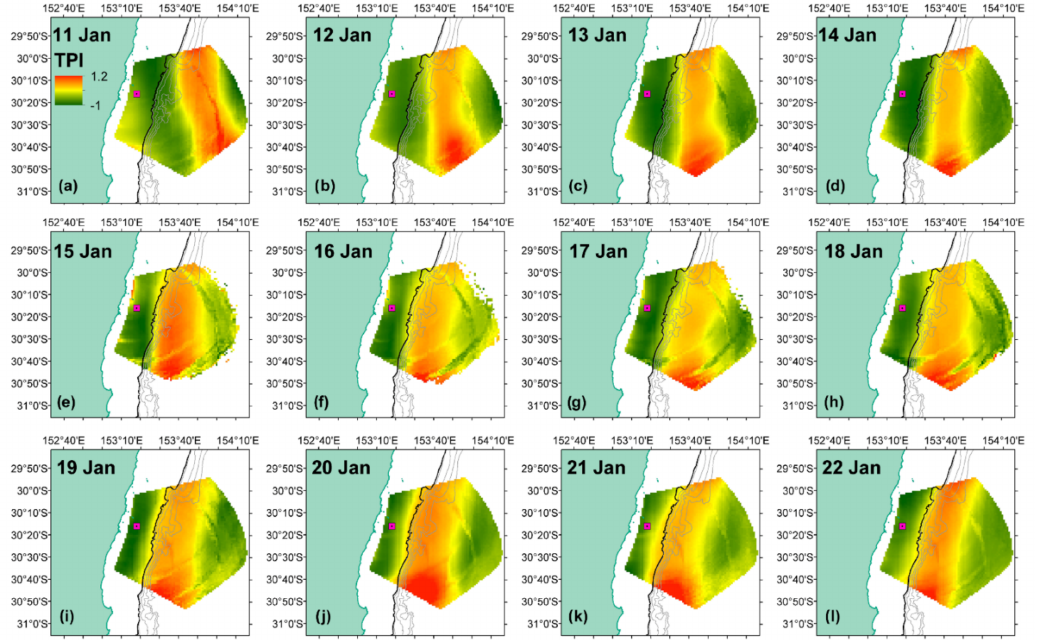
Figure 3. ( a – l ) TPI surfaces of the daily averaged surface current speed shown in Figure 2. The line and point symbols are as in Figure 1. The black line denotes the shelf